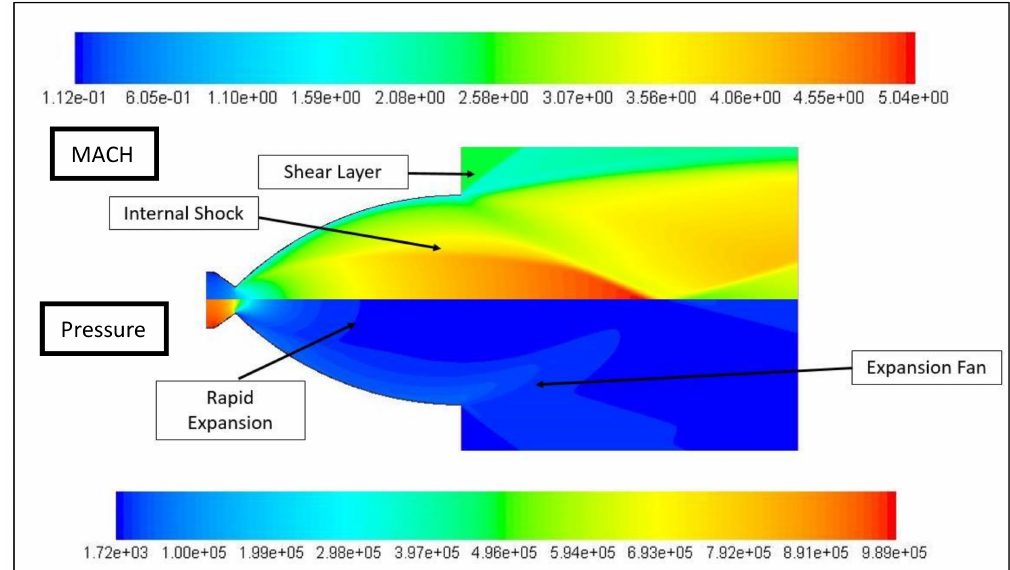
Figure 18. ( Top ) Pressure contour and ( Bottom ) Mach contour thrust = 1.58 × 106 N, NPR ≈ 90, H1 = 3.55, V1 = 2, R1 =